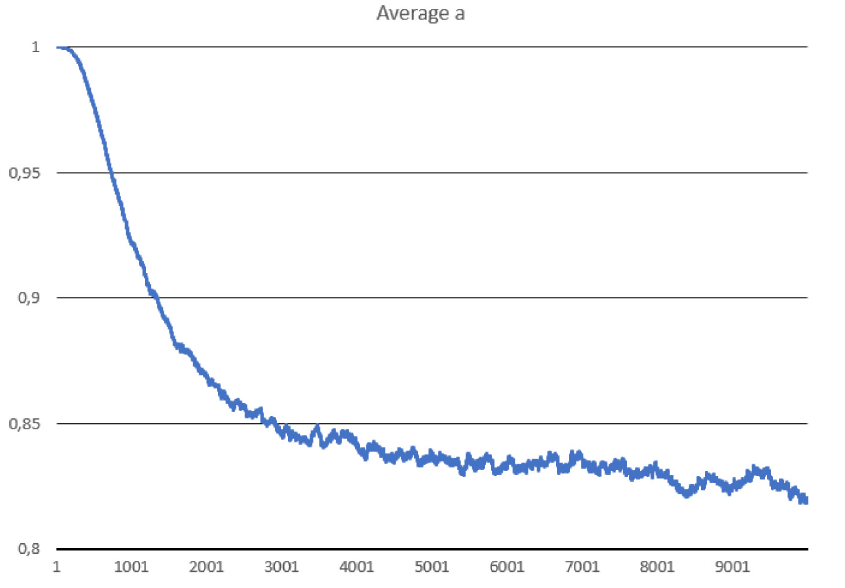
Fig 9. The average replication efficiency of replicases in Scenario